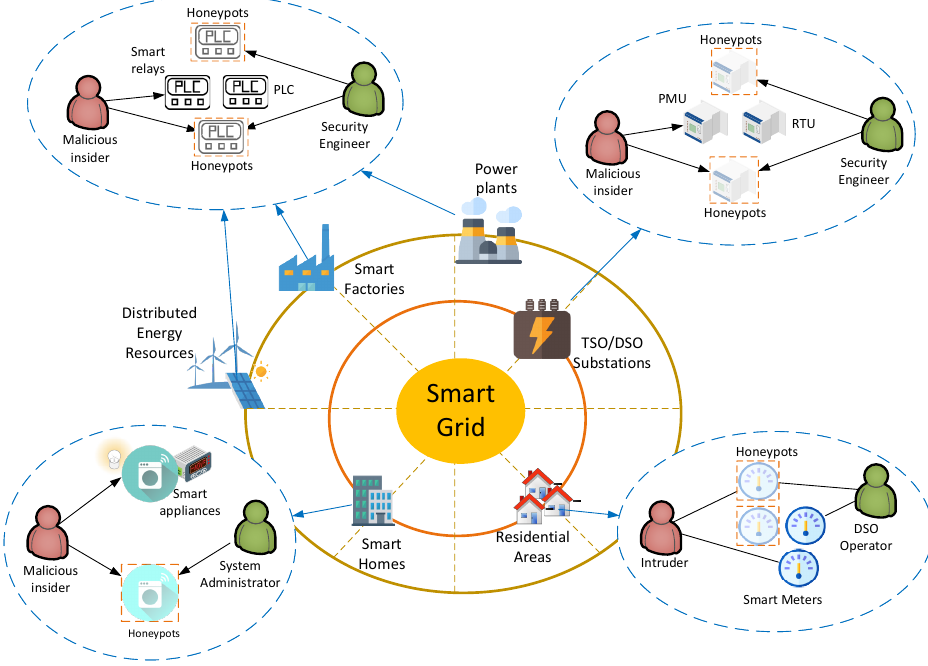
Figure 1. Depiction of various threats and possible honeypot deployments in smart